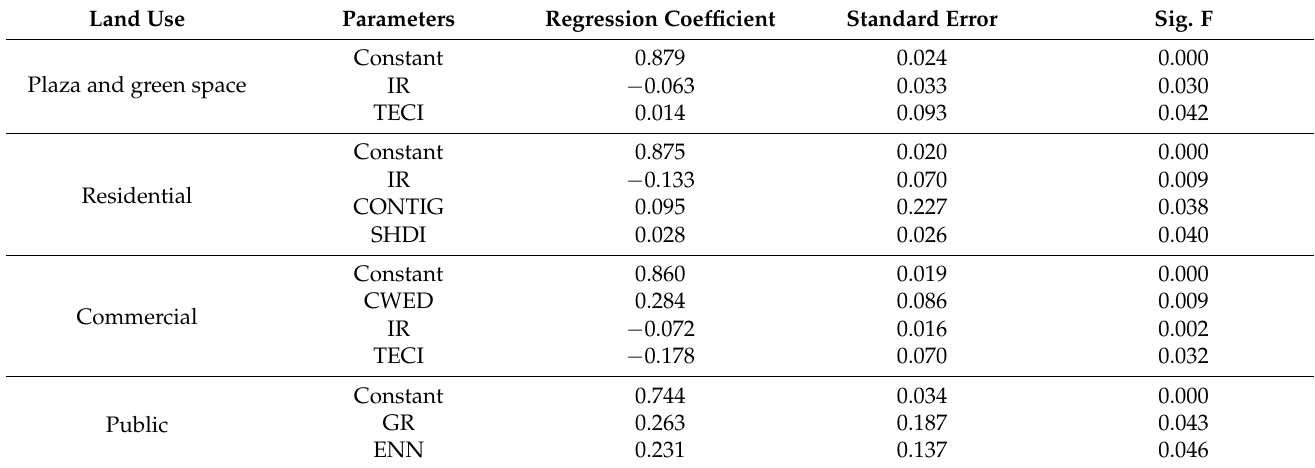
Table 4. Regression model reliability